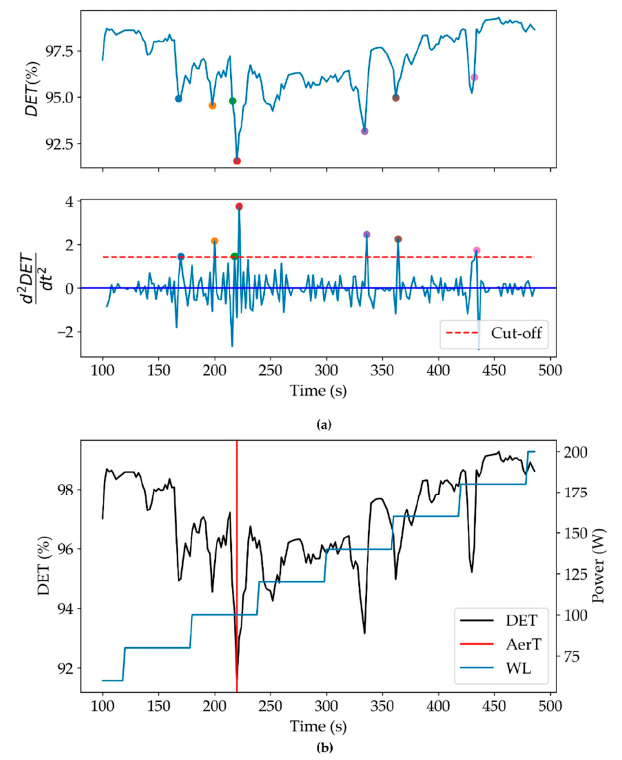
(cid:3118) (cid:3005)(cid:3006)(cid:3021) ; the dashed red (cid:3031)(cid:3047) (cid:3118)